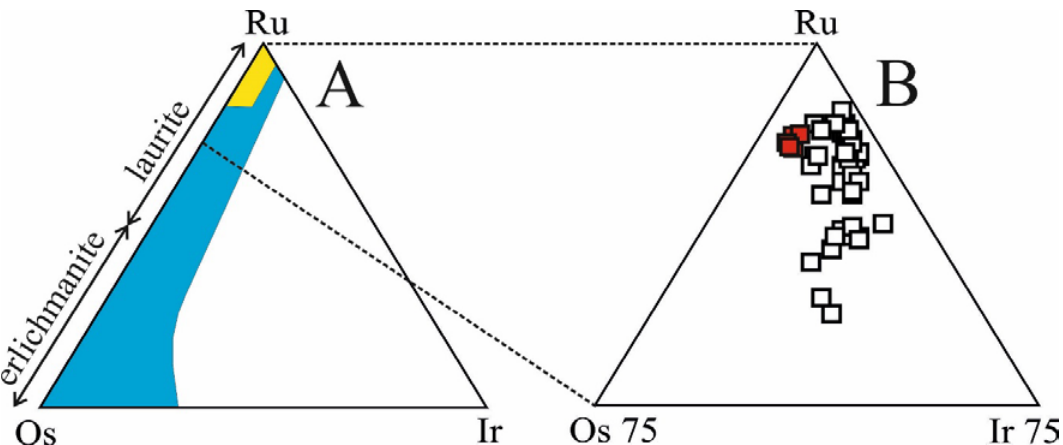
Figure 8. BSE image and X-ray element-distribution maps of S, As, Ru, Ir, Os, Pt, Cu, and Fe, showing the zoning of the laurite from the Merensky Reef, see reflected-light image of Figure 4C for the mineralogical assemblage. Scale bar is 20 µm.